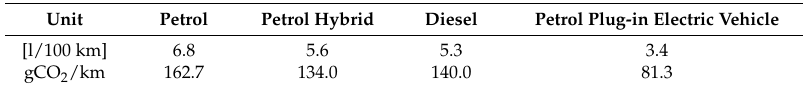
Table 2. Overview of the real-world tank-to-wheel fuel consumption indicators per technology (based upon